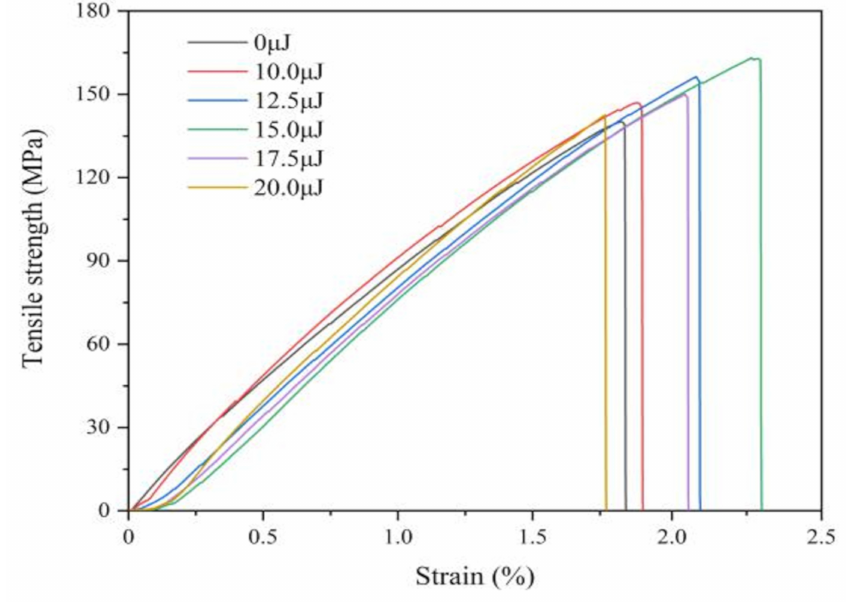
Figure 10. Tensile behavior of coatings with varying laser